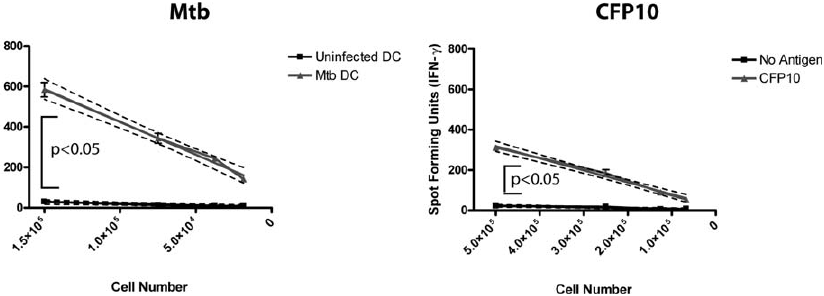
Figure 1. Determination of Human Effector Cell Frequencies Ex Vivo Using the IFN- c ELISPOT Assay Magnetic bead–purified CD8 þ T cells from a single donor (D466) were cultured with DCs (20,000/well) either infected with Mtb (H37Rv, multiplicity of infection ¼ 50) or pulsed with peptide pool representing CFP10 (5 l g/ml each peptide; 15-mer overlap by 11 aa) in an IFN- c ELISPOT assay. Each responding T cell population was tested in duplicate at four different cell concentrations. To determine the effector cell frequency of antigen-specific T cells, the average number of spot forming units per well for each duplicate was plotted against the number of responder cells per well. Linear regression analysis was used to determine the slope of the line, which represents the frequency of antigen-specific T cells. The assay was considered positive, reflecting the presence of a primed T cell response, if the binomial probability for the number of spots was significantly different by experimental and control assays, i.e., if the experimental line is statistically significantly different from the control line. The frequency of Mtb-specific and CFP10-specific T cells demonstrated in this figure was 1/307 and 1/1676,